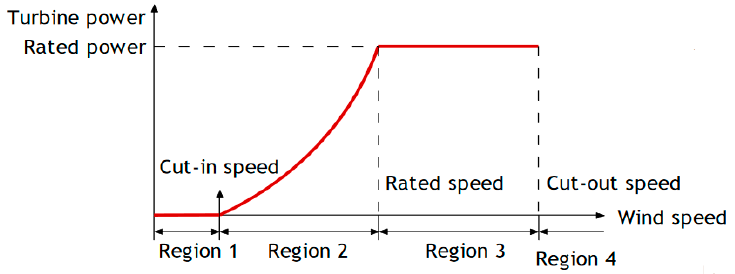
Figure 2. Wind Turbine Power Curve.